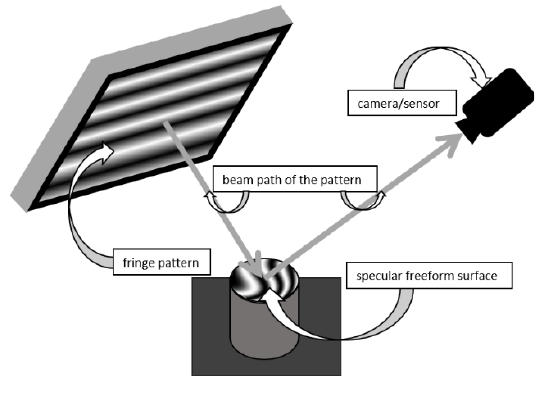
Fig. 1. Schematic of the PMD setup